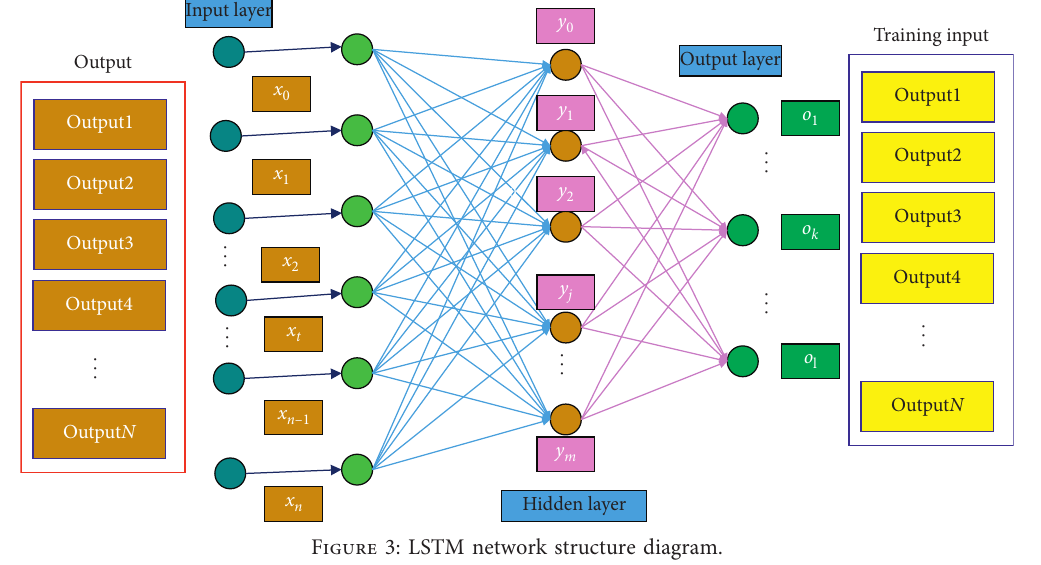
Figure 3: LSTM network structure